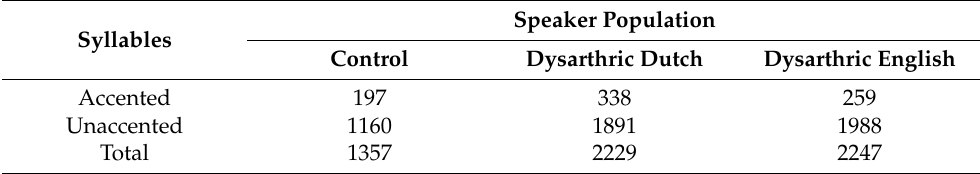
Table 4. Perceptually detected accented and unaccented syllables for each group of